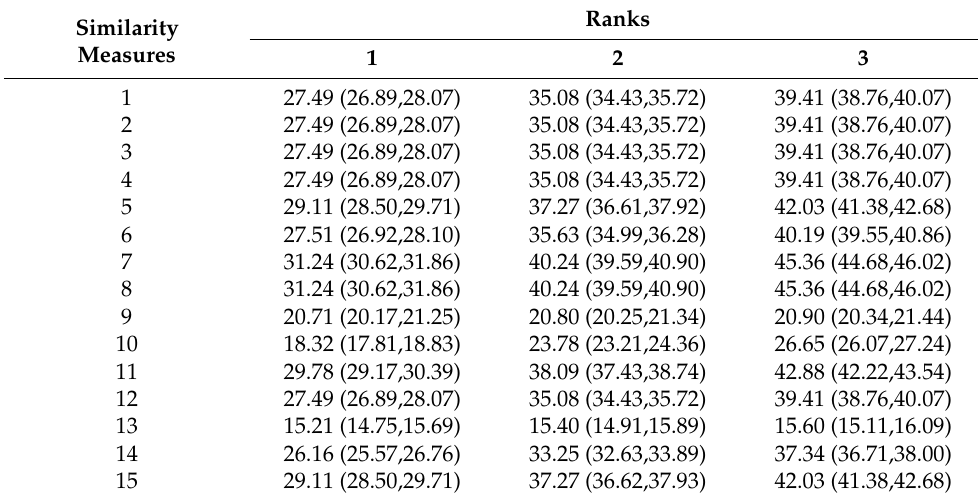
Table 1. Accuracy and 95% CI of the 15 binary similarity measures for the EI mass spectra-based compound identification up to the top three highest similarity scores.